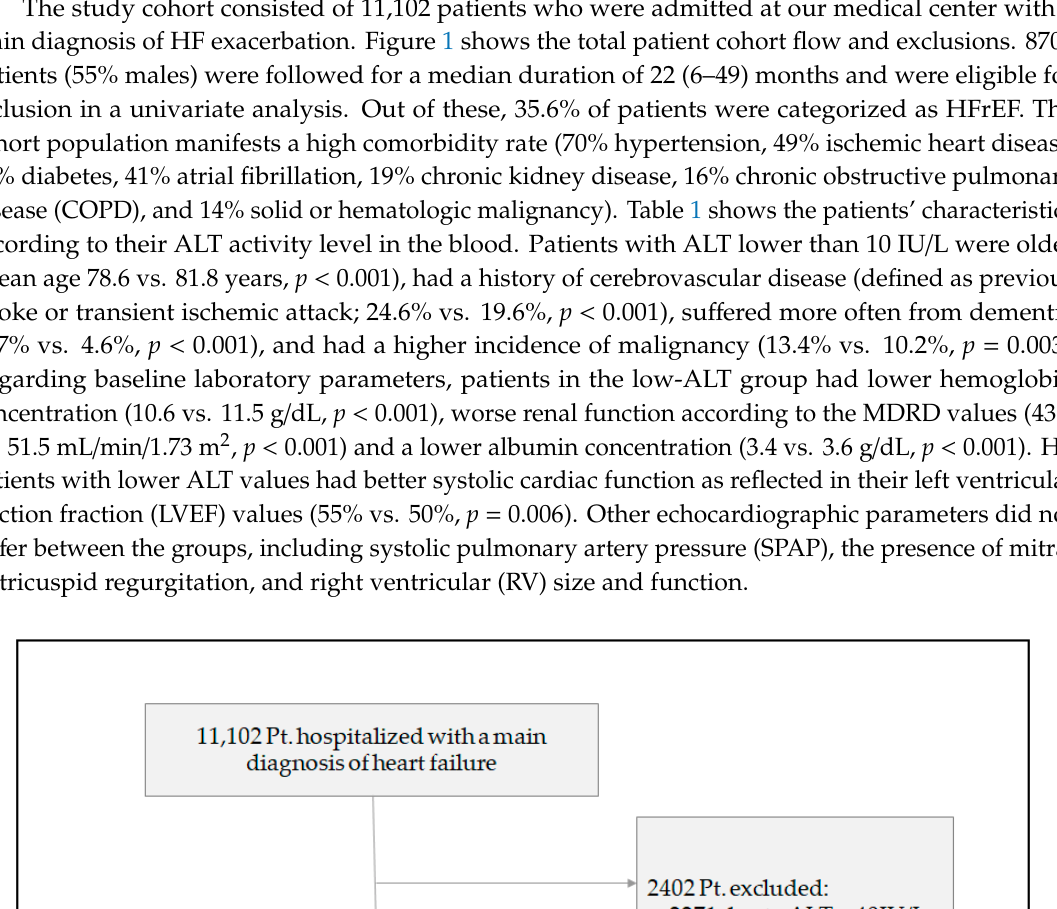
Figure 1. Flow and exclusions in the whole study cohort. LOS = length of (hospital) stay.